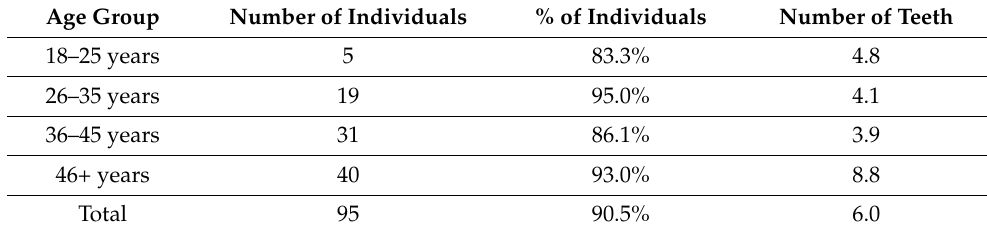
Table 3. Ante-mortem tooth loss (mean).